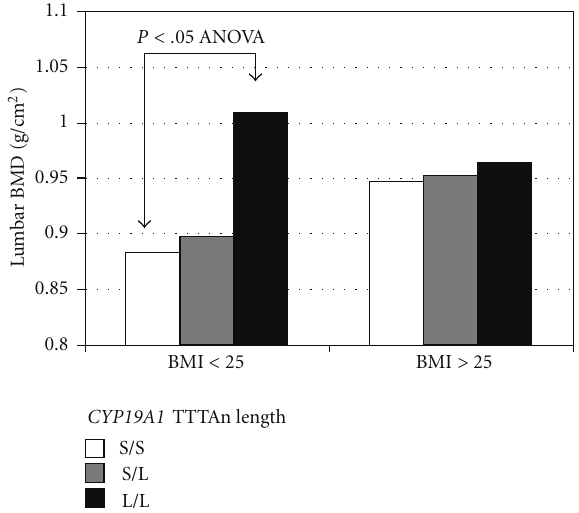
Figure 3: Lumbar BMD values according to CYP19A1 (TTTA)n repeat genotype in subjects divided by BMI in normal (BMI ≤ 25) and overweight or obese groups (BMI > 25), respectively.